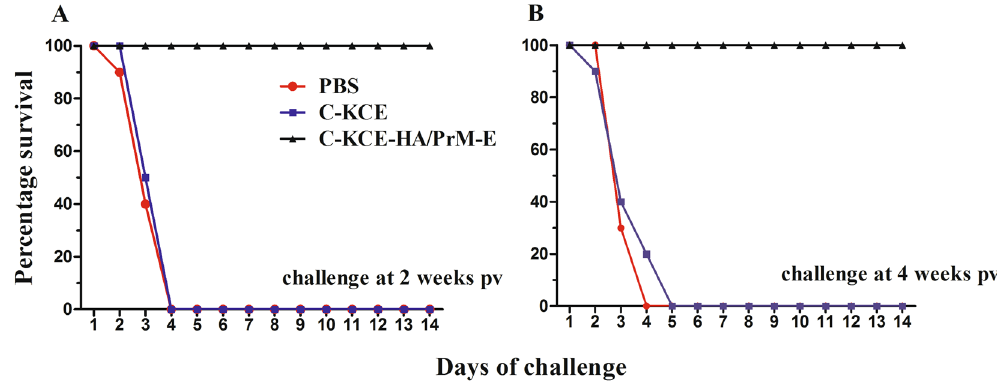
Figure 7. C-KCE-HA/PrM-E protection against HPAIV H5N1 challenge. Ducks were inoculated subcutaneously with 10 5 PFU of C-KCE-HA/PrM-E, 10 5 PFU of C-KCE, or PBS (n = 10 per group) as a control, following which they were intramuscularly challenged with 100-fold duck lethal dose (DLD) 50 XN/07 at 2 weeks ( A ) or 4 weeks ( B ) pv, respectively. The ducks were observed daily for 2 weeks following influenza virus